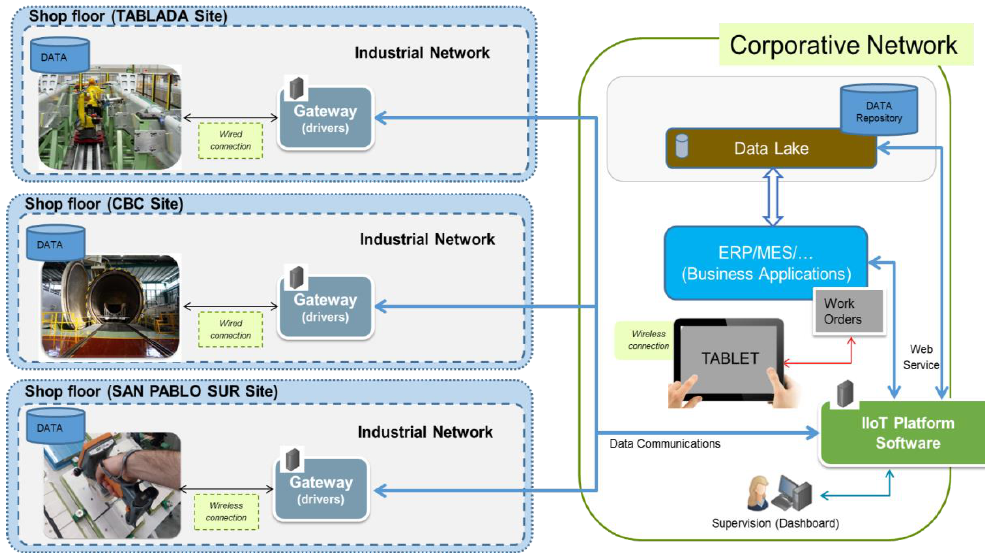
Figure 2. Architecture Aerospace Manufacturing Use-Case.